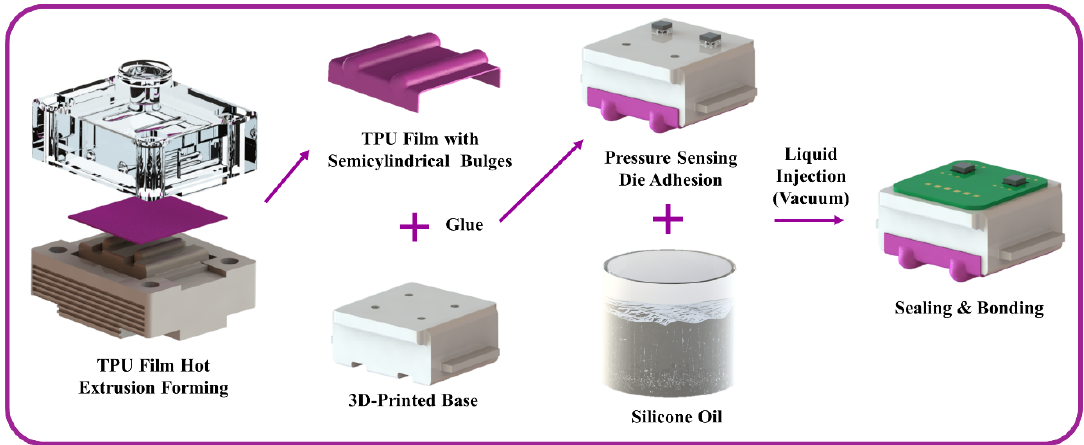
Figure 4. Preparation process of the sensing module.